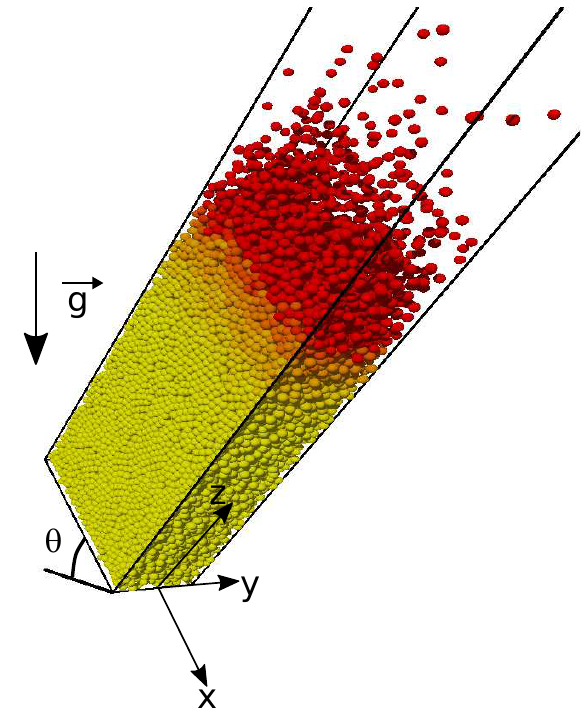
Figure 1. Typical snapshot for SSH flows: W / d = 10 and N = 15 , 000. The angle of the flow is θ = 45 ◦ , the coe ffi cient of restitution e n is equal to 0 . 88, and the grain-grain and grains- sidewall friction coe ffi cients (respectively f g and f w ) are set to 0 . 5. Flow is directed down the incline along the x -axis. Two sidewalls confining the system are parallel to the ( xz ) plane.